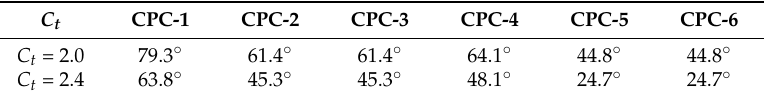
Table 2. Edge-ray angle of truncated CPCs with θ a = 20 ◦ . Table 3. Depth of CPCs with θ a = 20°.